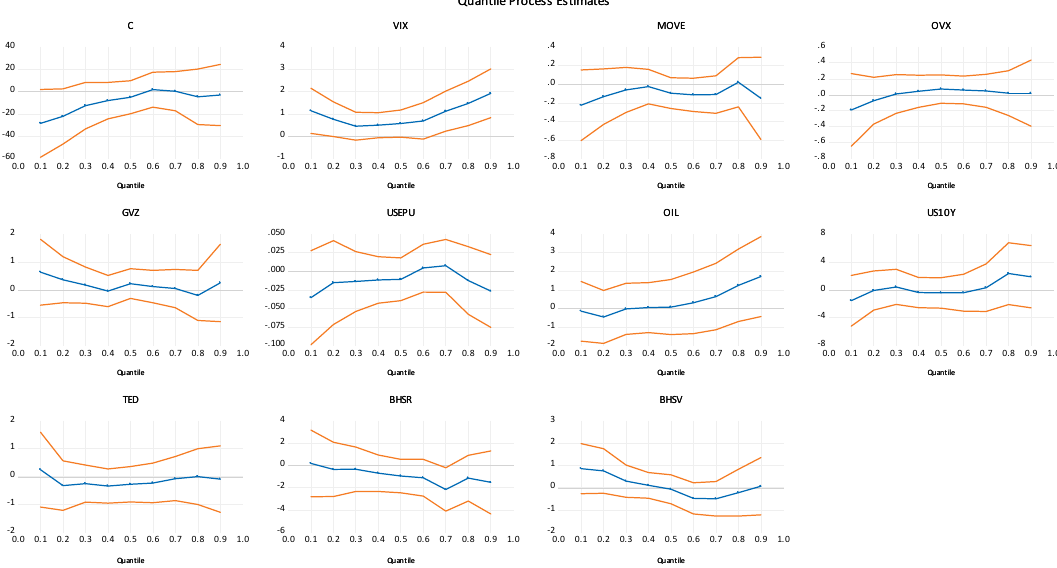
Figure 7. Quantile regression coefficient estimates in the case of Bahrain, with 95% confidence intervals. Vertical axes show the coefficient estimates of the explanatory variable over the Bahrain CDS spreads distribution. Horizontal axes show the quantiles of the dependent variable.